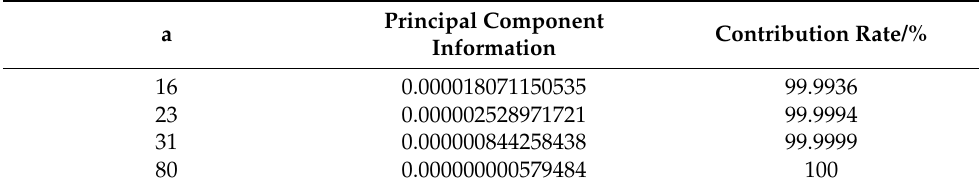
Table 9. Some of the principal component analysis